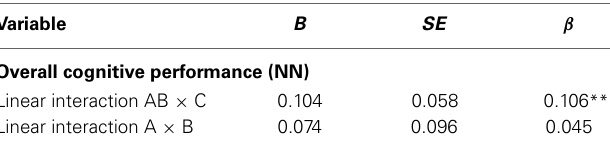
Table 10 | Multiple regression for the interaction between orthogonal contrasts and training gain for the composite score of the cognitive